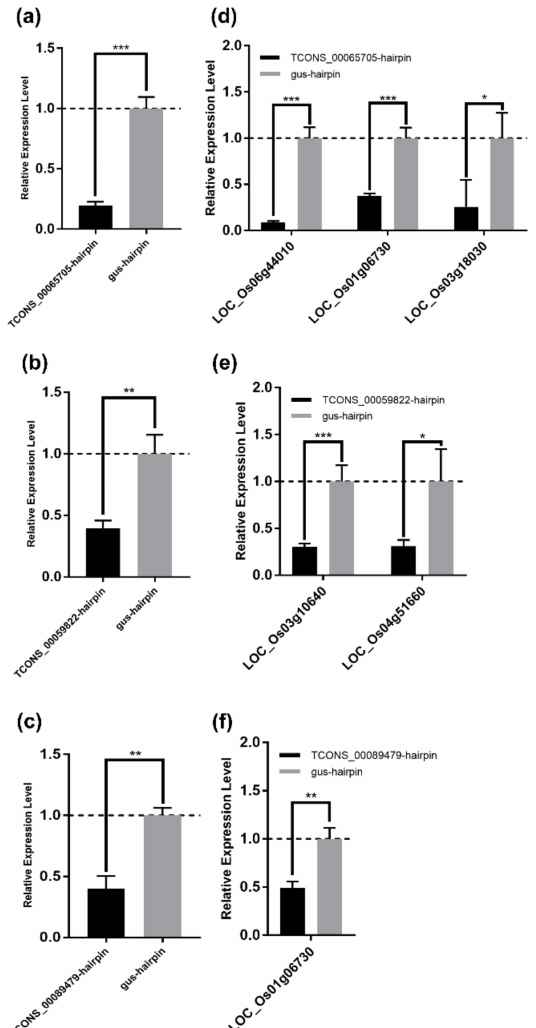
Figure 8. Experimental validation of the lncRNA–mRNA regulatory relationship in the DElncRNA–DEmRNA co-expression network. ( a – c ) The silencing of the lncRNA TCONS_00065705 ( a ), TCONS_00059822 ( b ), and TCONS_00089479 ( c ) was confirmed by qRT-PCR. Total RNA of rice callus was extracted at 7 days after Agrobacterium infection. OsUBC gene served as an internal reference for the relative quantification. The values represent means of the lncRNA expression levels ± standard deviations (SD) relative to the gus-hairpin-expressed callus tissues ( n = 3 biological replicates). Data were analyzed by the Student’s t -test, and asterisks denote significant differences between lncRNA-silenced and gus-hairpin-expressed callus tissues (two-sided, ** p < 0.01, *** p < 0.001). ( d – f ) qRT-PCR analyses of the mRNA co-expressed with TCONS_00065705 ( d ); TCONS_00059822 ( e ); and TCONS_00089479 ( f ). Total RNA in ( a – c ) was used for qRT-PCR analyses. OsUBC gene served as an internal reference for the relative quantification. The values represent means of the mRNA expression levels ± standard deviations (SD) relative to the gus-hairpin-expressed callus tissues ( n = 3 biological replicates). Data were analyzed by the Student’s t -test, and asterisks denote significant differences between lncRNA-silenced and gus-hairpin-expressed callus tissues. (two-sided, * p < 0.05, ** p < 0.01, *** p <